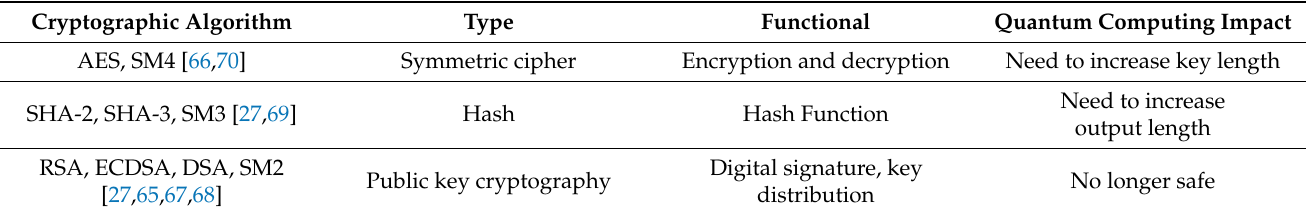
Table 6. The impact of quantum computers on classical